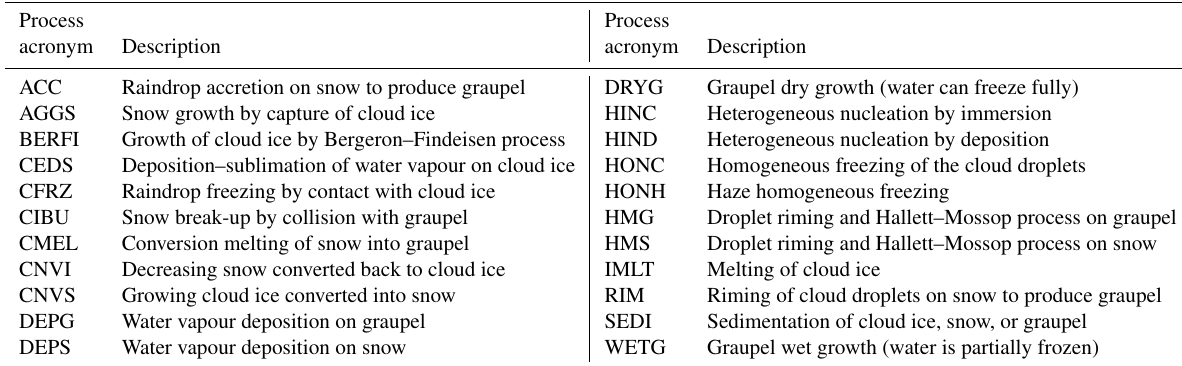
Figure 7. “RANDOM” case of the STERAO simulations showing the mixing ratios of (a) the cloud ice ( r i ), (b) the snow aggregates ( r s ), and (c) the graupel ( r g ) at 12km height. Panel (d) refers to the number concentration of the cloud ice crystals ( N i ) at 15km height. The plots are for a fraction of the computational domain. Table 3. Nomenclature of the microphysics processes of the budget